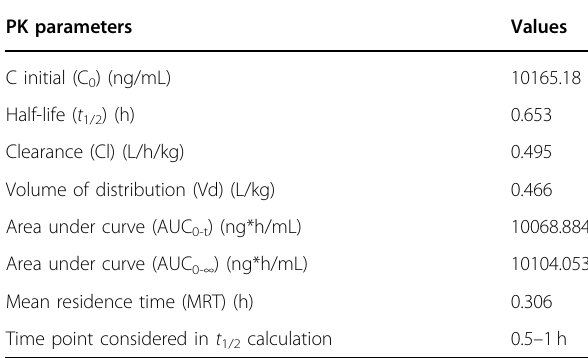
Table 1 Pharmacokinetic parameters of 4DPG in Balb/c mice intravenously administered with a single dose of 5 mg/kg/body